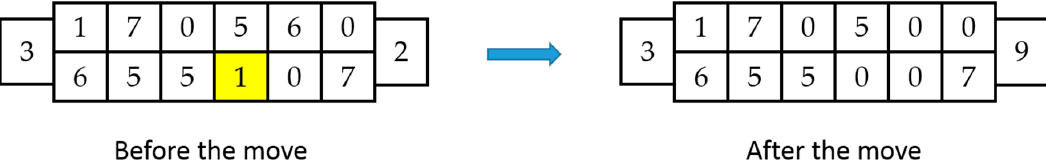
Figure 5. A move leading to the capture of the opponent’s seeds. The selected pit to be sawed is highlighted in yellow.